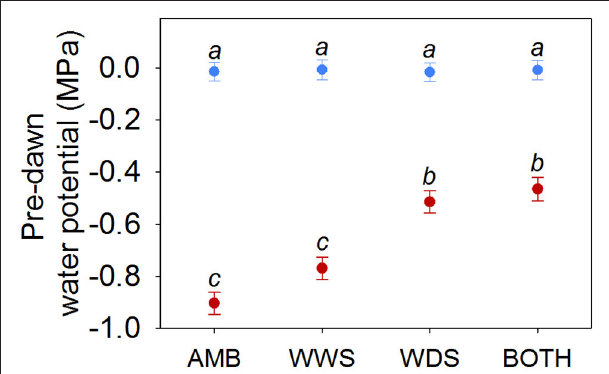
FIGURE 2 | Least-squares means ( ± SE) for pre-dawn water potential (MPa) in the dry season (red) and wet season (blue). AMB, ambient; WWS, watering in the wet season; WDS, watering dry season; BOTH, watering in both seasons. Homogeneous groups at the 95% confidence level are presented by the same letter for treatment by season